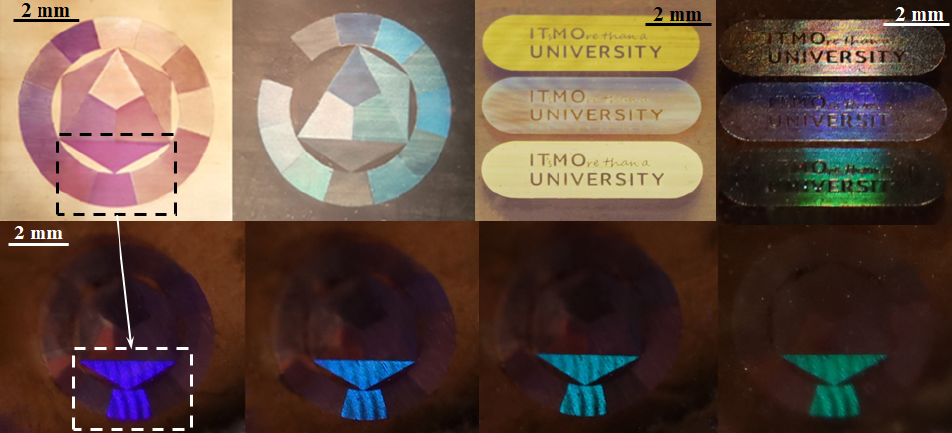
Figure 5. Examples of nanocomposite gratings applications: a color spectrum, where each sector was obtained with different laser processing parameters (transmission and reflection photos for different angles of illumination); ITMO University Logo—photos in reflection and scattering